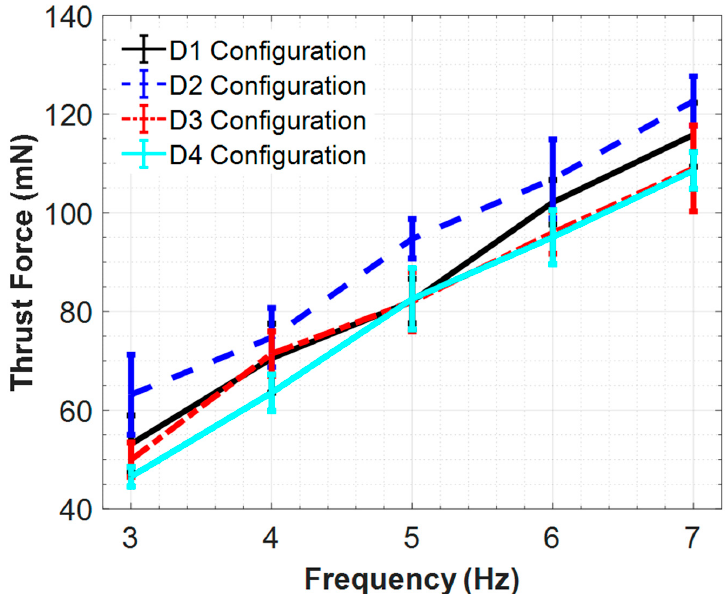
Figure 10. PIV thrust force results of the two bundled flagella for four different configurations in 30,000 cSt silicone oil. Error bars correspond to simultaneous thrust measurements with 20 to 1 confidence level.